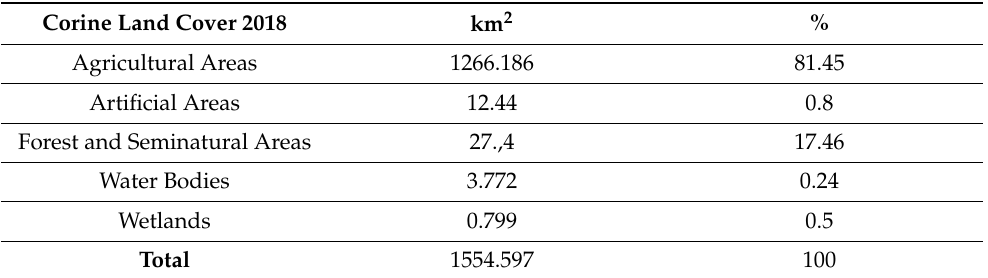
Table 1. Land cover based on Corine Land Cover II Level expressed in km 2 and percentage (%).